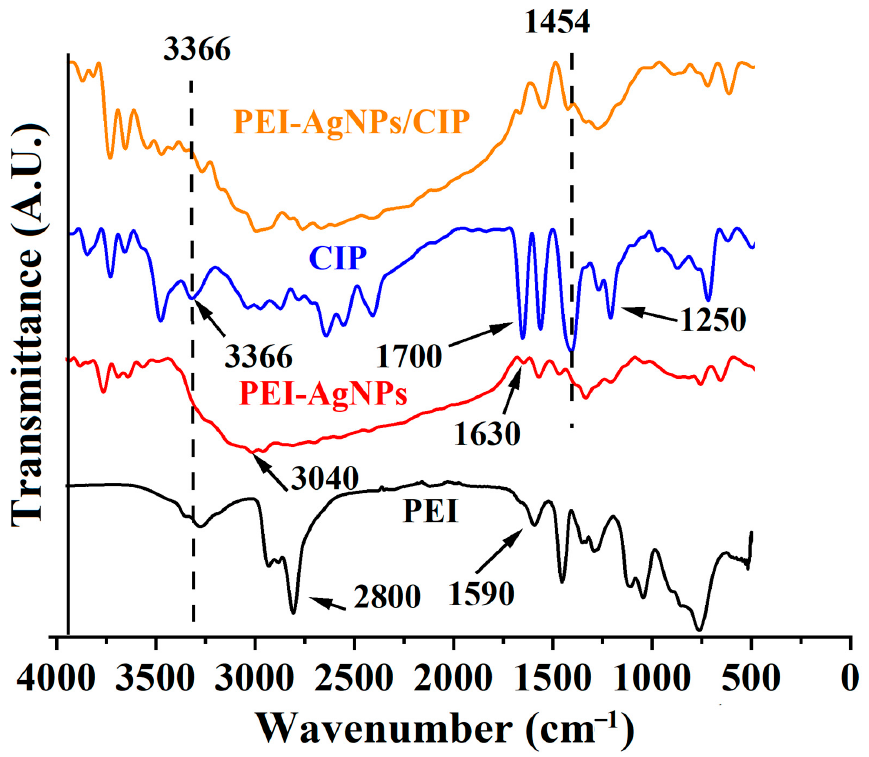
Figure 4. FTIR spectra of PEI, PEI-AgNPs (1:15), CIP, and PEI-AgNPs (1:15)/CIP (1.0 mM).